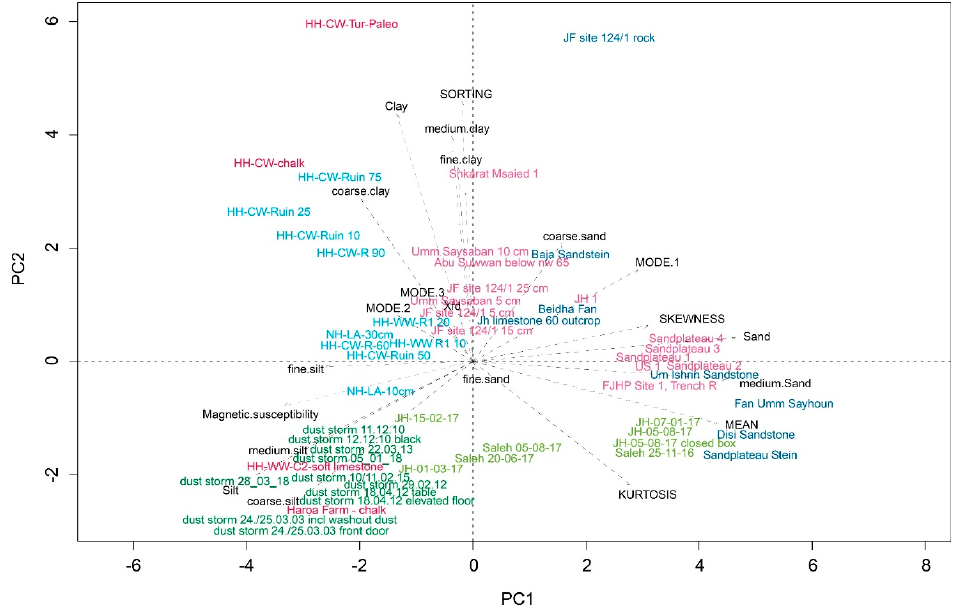
Figure 13. PCA biplot based on the nine grain size classes, magnetic susceptibilities, and statistical parameters related to particle-size distribution, such as the main modes and mean grain sizes. The relative locations of the samples reflect their respective similarity with regard to the first and second principal component. The parameters that are most relevant for this distribution are shown in black, along with dashed lines referring to their relative spatial direction, with regard to the principal